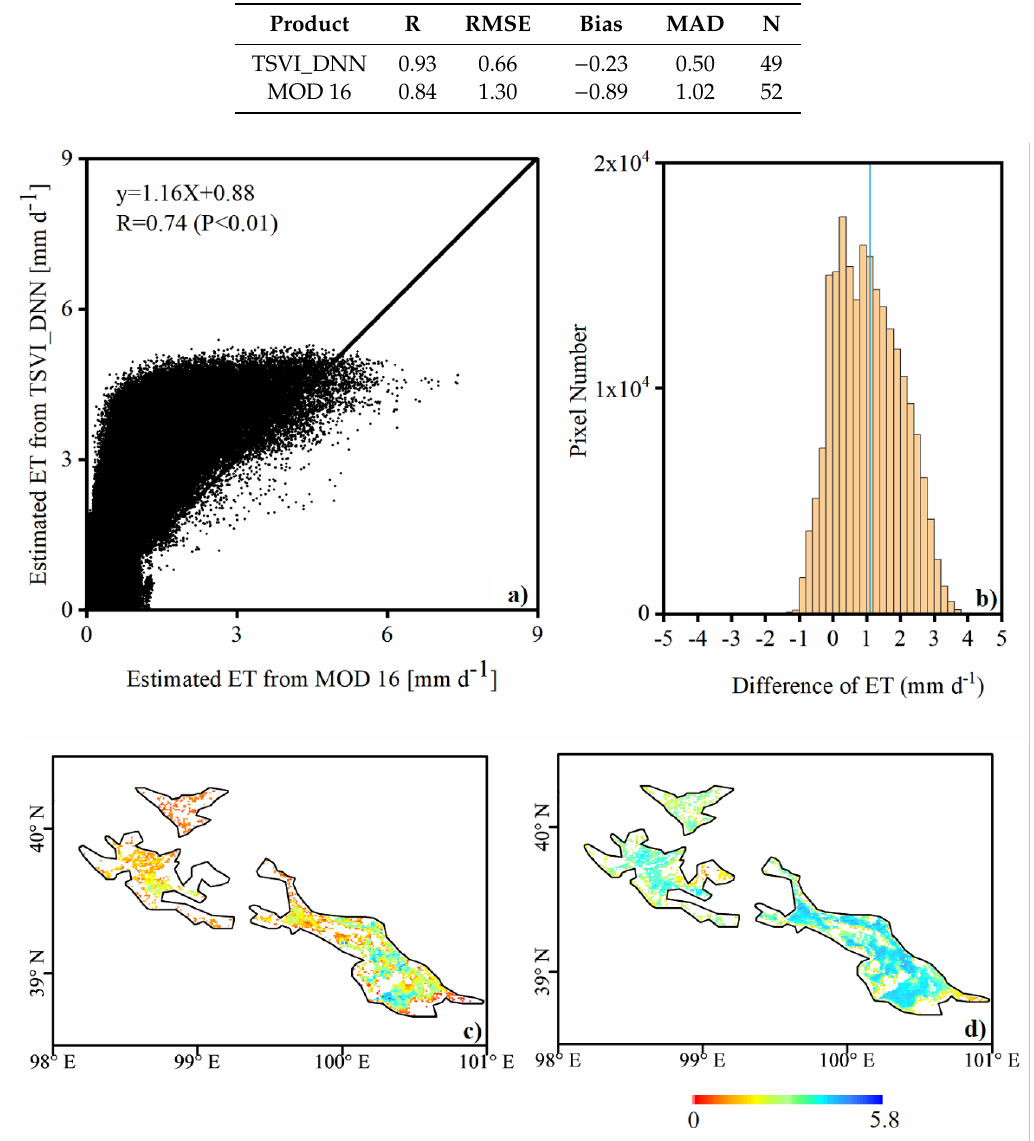
Table 2. Error metrics of ET estimates from the TSVI_DNN model and MOD16 ET product as compared to in situ measurements at the YK station during 2009–2011, including R (correlation coe ffi cient), RMSE (root mean square error, mm d − 1 ), bias (mean bias, mm d − 1 ), MAD (Mean Absolute Deviation, mm d − 1 ), and N (the number of samples).